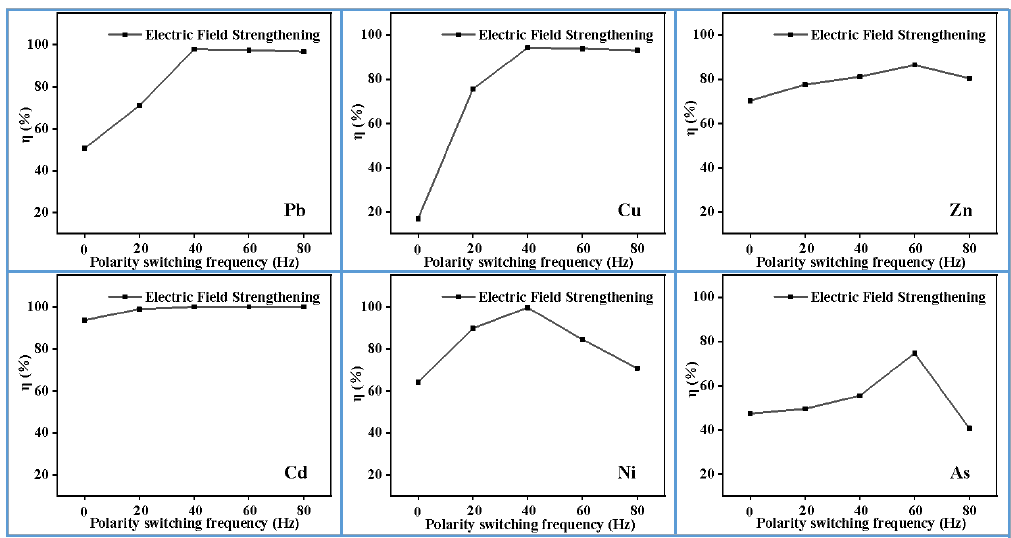
Figure 7. Effect of periodically switched polarity on heavy metals efficiency (0.5 mol/L EDTA, 35 mA/cm 2 , pH = 2, 2 h).